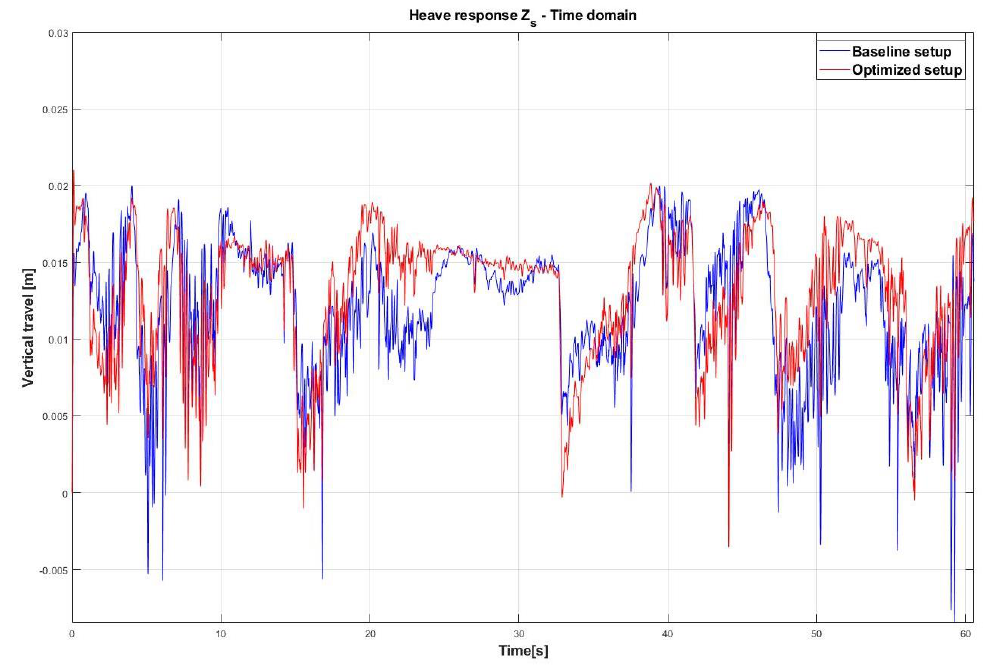
Figure 24. Comparison between the baseline provided setup and improved setup for heave response of the car in the time